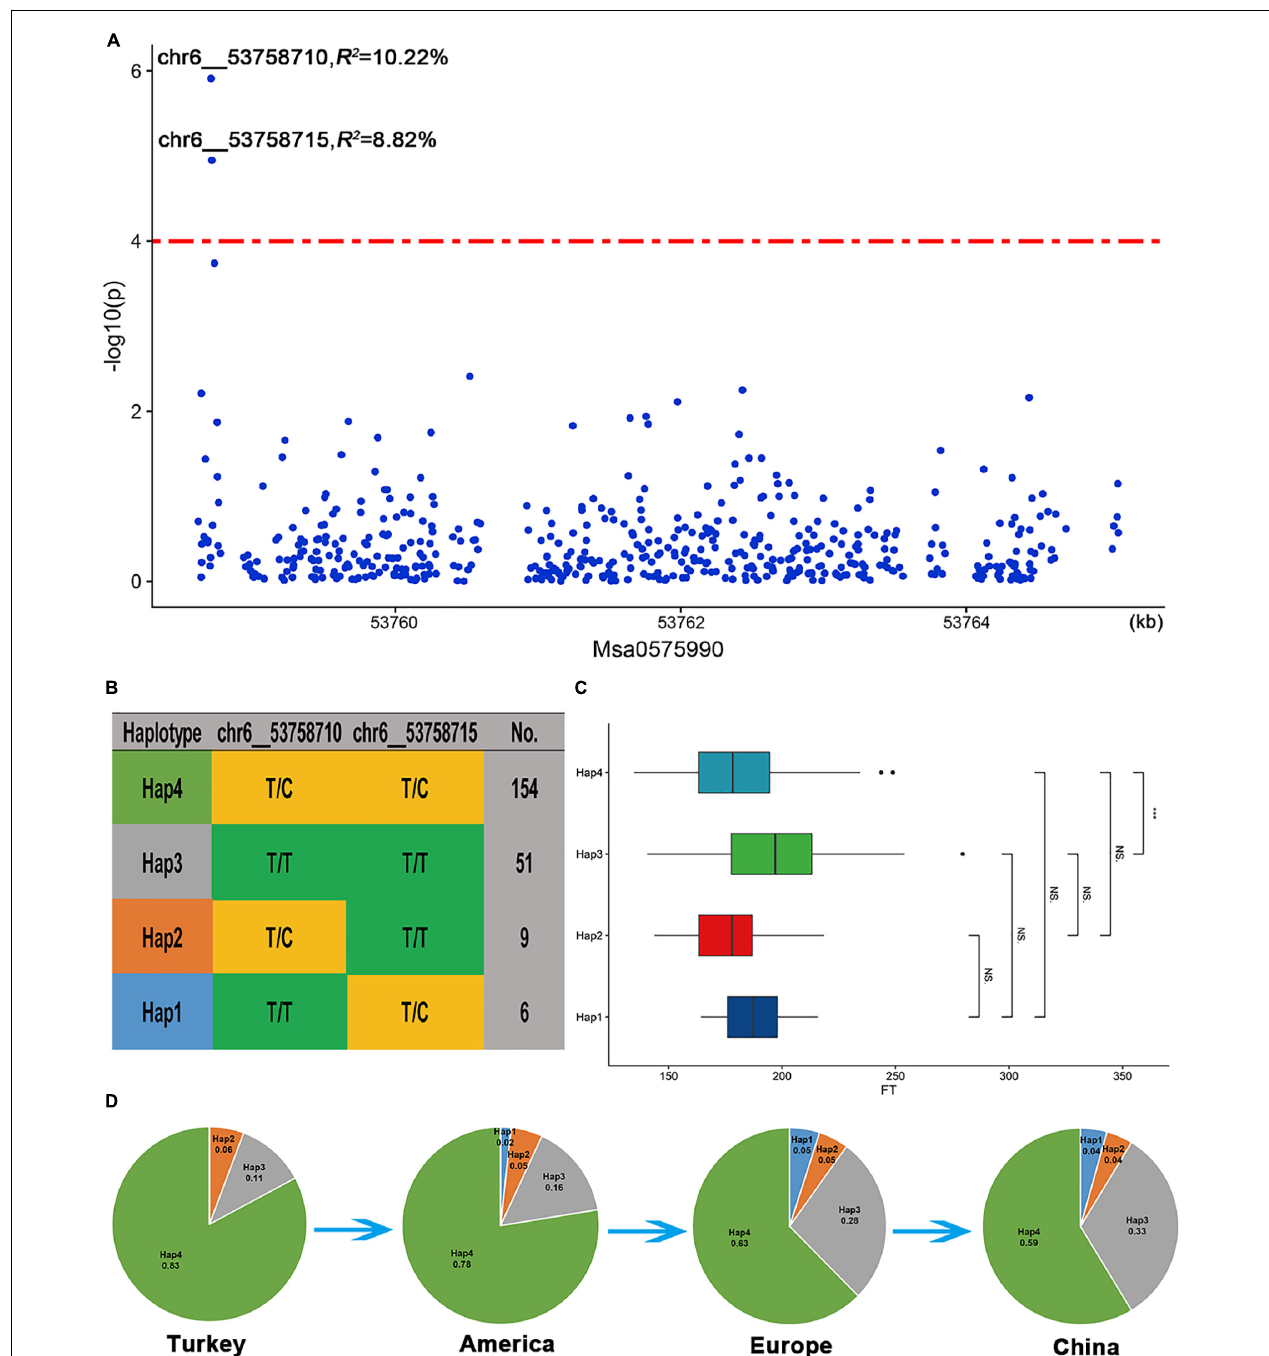
FIGURE 7 | Msa0888690 involvement in the flowering time in alfalfa. (A) Association analysis of SNPs located within the Msa0888690 gene region. (B) Haplotype analysis of significant SNPs associated with the flowering time. (C) Comparison of the flowering time among the four haplotypes. A boxplot of the four haplotypes is shown on the left, and the symbols represent the correlations. (D) Allele frequency of the four haplotypes in the Turkish, American, European and Chinese